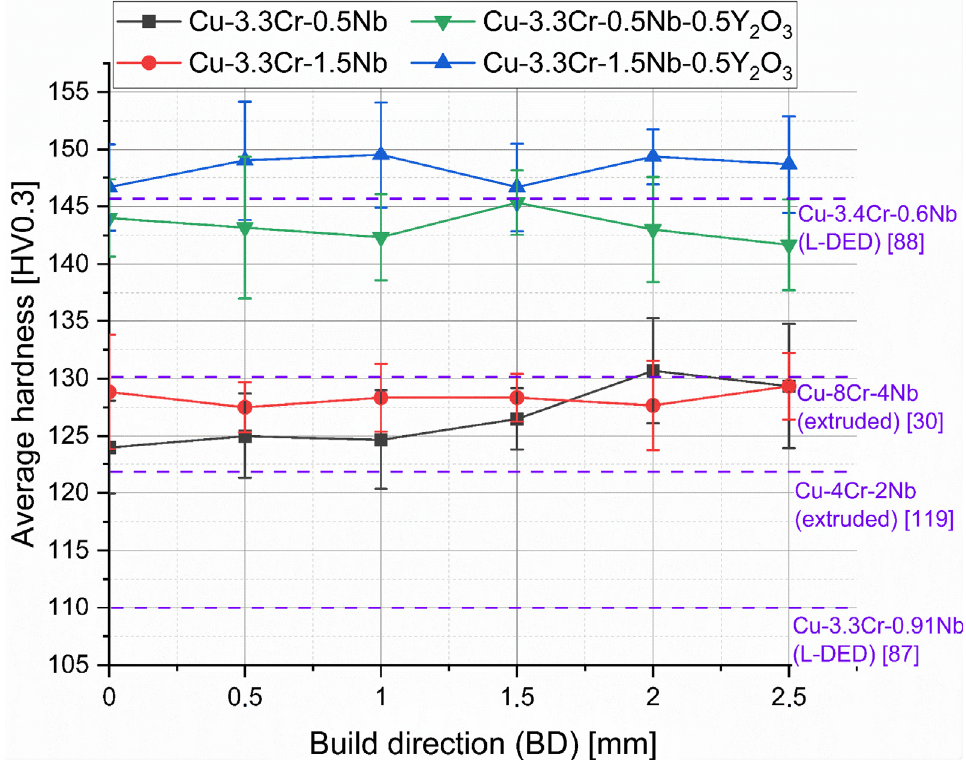
Figure 8. Hardness line profiles of manufactured specimen of Cu-3.3Cr-0.5Nb (black line), Cu-3.3Cr-1.5Nb (red line), Cu-3.3Cr-0.5Nb-0.5Y 2 O 3 (green line), and Cu-3.3Cr-1.5Nb-0.5Y 2 O 3 (blue line). Hardness values of Cu-Cr-Nb alloys manufactured by extrusion and laser directed energy deposition (L-DED) are shown in purple with their respective reference.